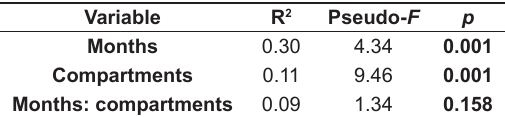
Table 4. PERMANOVA of the months and compartments sampled in relation to abundance and species composition of microcrustaceans in the reservoir Barragem da Pedra, Jequié.